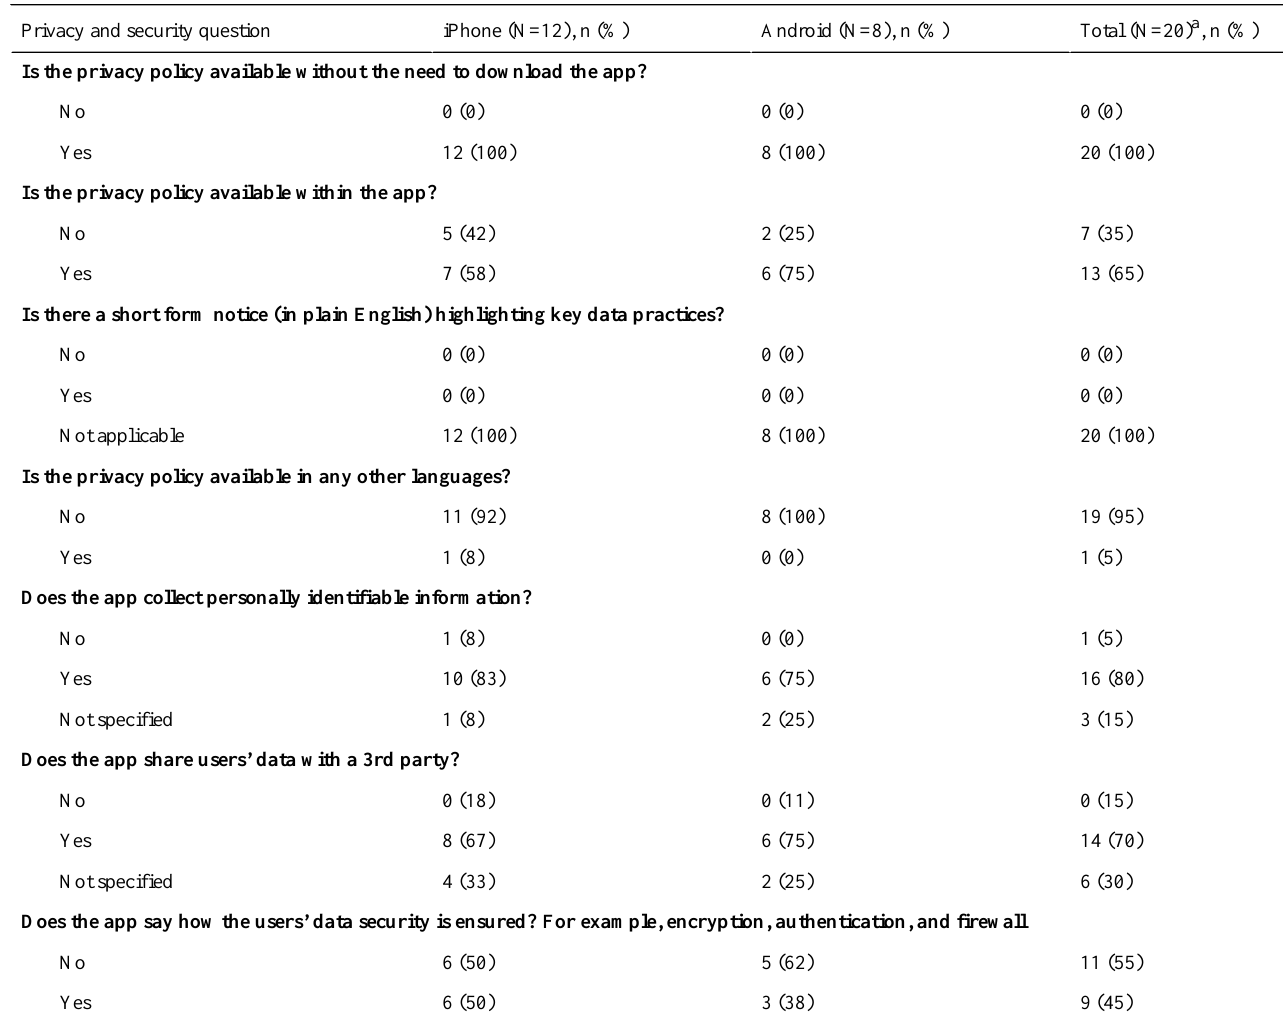
Table 3. Data privacy and security assessment of apps (data gathering, sharing, and security) on the basis of the description in the privacy